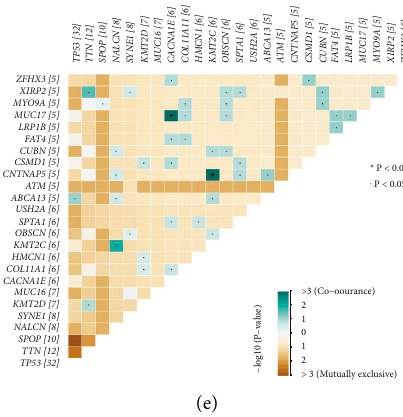
Figure 2: SNV comparisons in patients at a low and high risk of bone metastasis. (a) Mutational landscape profile for prostate cancer patient samples, with the waterfall plot being used to show mutational information for each gene, while colors with specific annotations along the bottom of the plot denote specific types of mutations. Mutational burden is shown in a bar plot above the legend. MB, metastasis of bone. (b) TMB value for the LRBM and HRBM cohorts. Violin plots represent TMB values as dots, with a box plot being present within this violin plot. ∗ P < 0 . 05, ∗∗ P < 0 . 01, ∗∗∗ P < 0 . 001; two-sided Mann–Whitney U test. (c) Differentially mutated genes were compared between the LRBM and HRBM cohorts with the “mafCompare” function in the R “maftools” package. ∗ P < 0 . 05, ∗∗ P < 0 . 01, ∗∗∗ P < 0 . 001. (d-e) Coincident and exclusive associations among mutated genes within the (d) LRBM and (e) HRBM